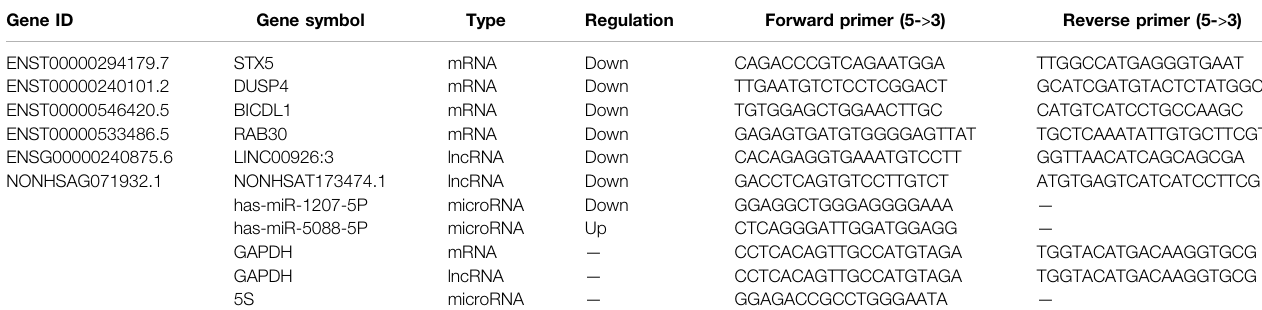
TABLE 1 | Characteristics of selected mRNAs in qRT-PCR validation.